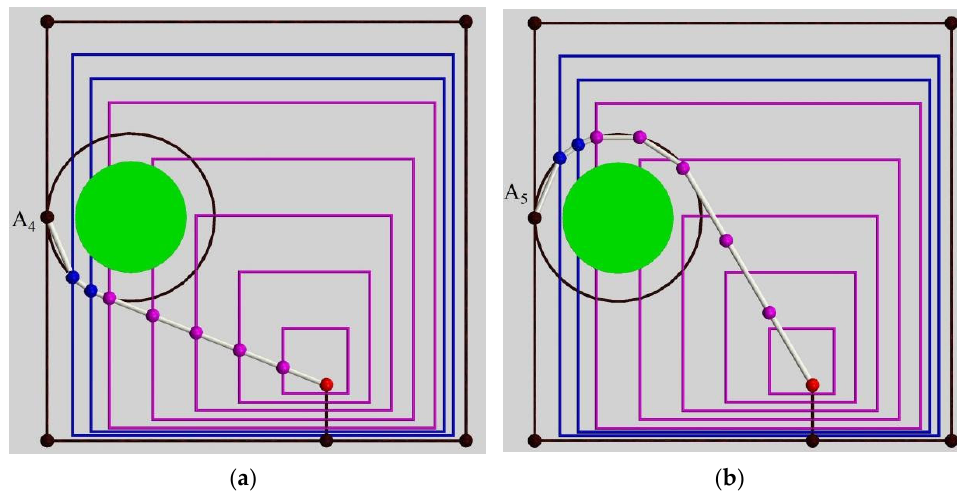
Figure 7. Two-dimensional projection diagram of the manipulator. ( a ) End-effector is located at A 4 ; ( b ) End-effector is located at A 5 .